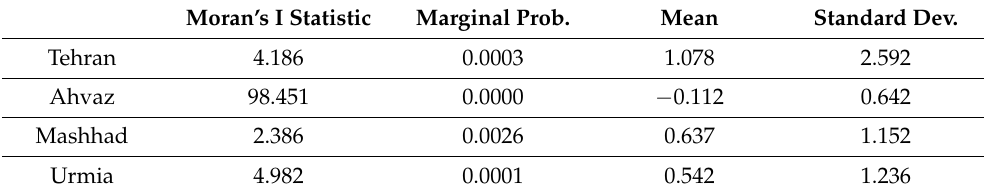
Table 2. Moran test for self-correlation in perturbation components of the electrical model.